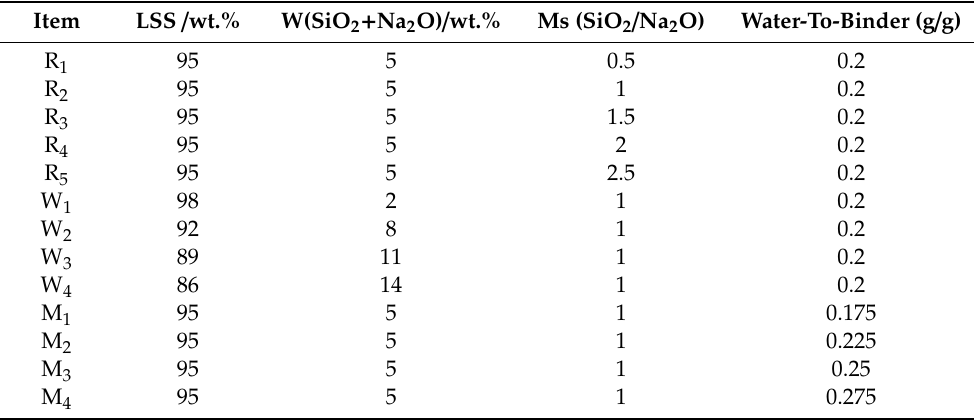
Table 2. The formulation design of the LSS-based geopolymer